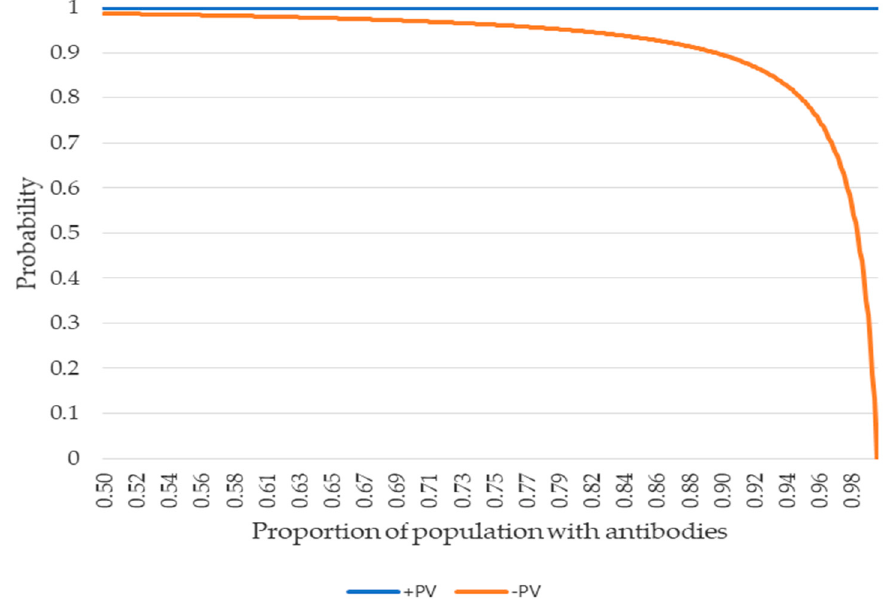
Figure 1. From the estimated sensitivity and specificity, the evolution of the positive (+PV) and negative (-PV) predictive values is shown for populations with a proportion of presence of antibodies greater than